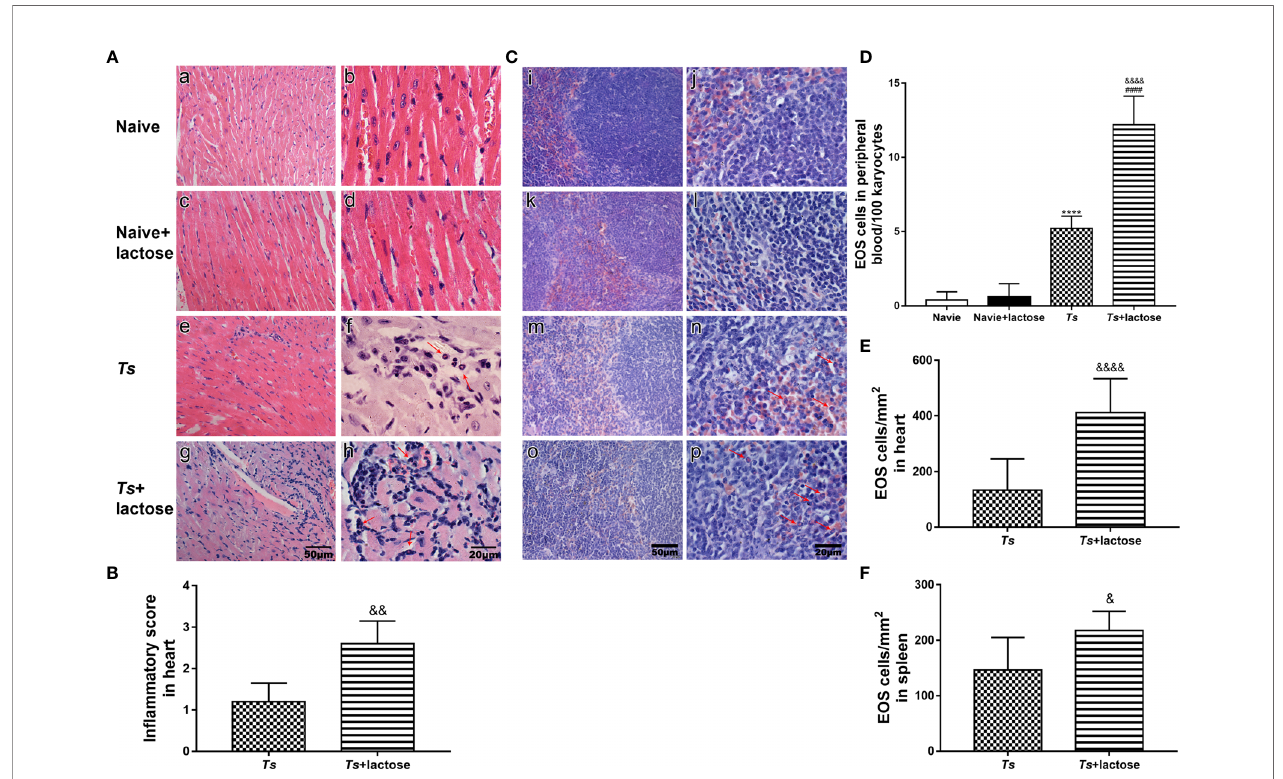
FIGURE 1 | Histopathology and eosinophil counts in different groups of mice. Histopathology of heart (A) and spleen (C) . No histopathological changes and eosinophils were observed in the heart (a, b) and spleen (i, j) tissues of uninfected mice and in the heart (c, d) and spleen (k, l) tissues of uninfected mice with a -lactose treatment. Histopathological changes and obvious in fl ammation were observed in the heart (e, f) and spleen (m, n) tissues of T. spiralis -infected mice and in the heart (g, h) and spleen (o, p) tissues of T. spiralis -infected mice plus a -lactose treatment. Eosinophils indicated by red arrows were observed in the heart and spleen tissues of T. spiralis -infected mice and T. spiralis -infected mice plus a -lactose treatment. Original magni fi cation 400× (scale bar = 50 µm) for a, c, e, g, i, k, m, and o; 1000× (scale bar = 20 µm) for b, d, f, h, j, l, n, and p; H&E stain. (B) Histopathological score analysis of the heart. (D) The eosinophil (EOS) count in the peripheral blood. Quantitative analysis of eosinophils in the heart (E) and spleen (F) . The density of eosinophils was expressed as the number of eosinophils per square millimeter. Data are presented as means ± SD; there were eight mice in each group and the data shown are representative of those from two different experiments. **** P < 0.0001 vs . uninfected control mice. #### P < 0.0001 vs . uninfected mice or uninfected mice with a -lactose treatment. & P < 0.05, && P < 0.01, and &&&& P < 0.0001 vs . T. spiralis -infected